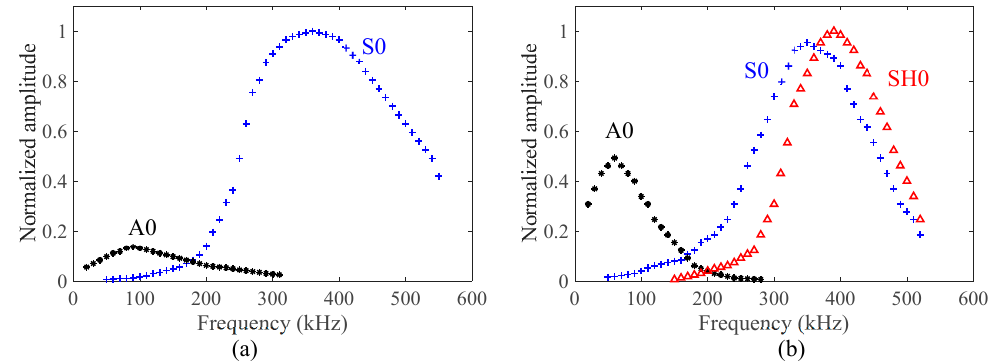
Figure 14. Experimental tuning curves of the cross-ply CFRP composite plate in the: ( a ) 0° directions; ( b ) 45° direction.